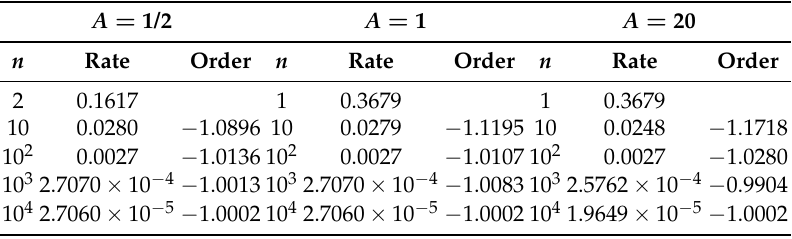
Table 3. Uniform convergence rate and convergence order for exponential distribution.